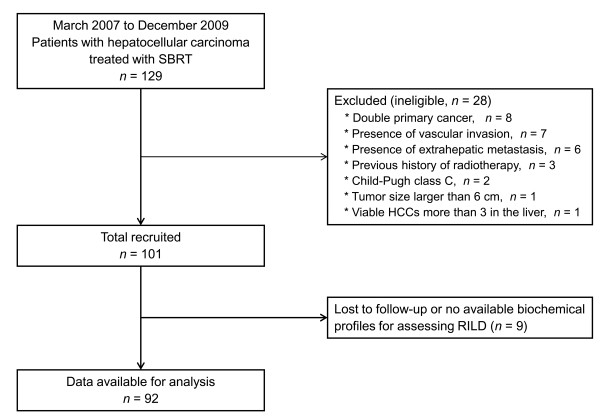
Flow diagram of the present study.